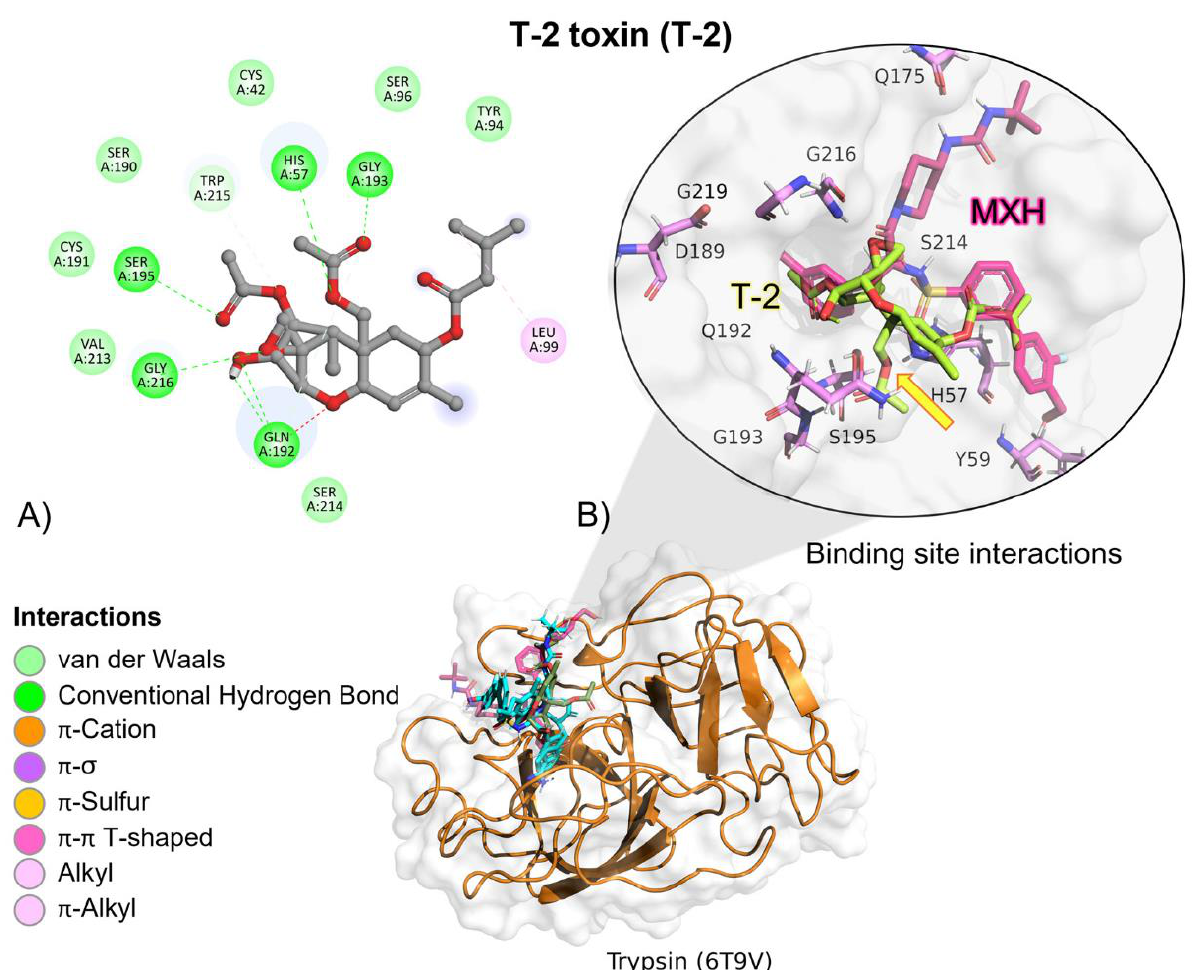
Figure 9. T-2 toxin–trypsin interactions. ( A ) Detailed view showing the interactions of the main different amino acid residues in trypsin with the T-2 toxin ligand. ( B ) Panoramic view of the reference (MXH) and the tested T-2 toxin ligands in trypsin. Comparison between the docked pose of the tested and the reference ligand within the bromelain binding pocket. The yellow arrow indicates the proximity between the trypsin catalytic triad and the T-2 toxin.